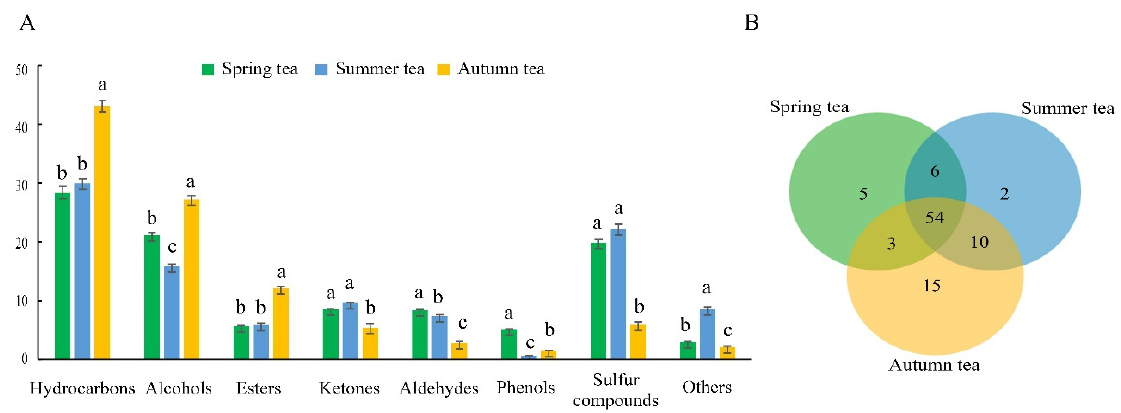
Figure 1. Comparison of the volatile components in tea samples from different seasons: ( A ) the classification of volatile components; and ( B ) Venn diagram of volatile components. Different lowercase letters in the same volatile categories indicate significant differences at p < 0.05 level.